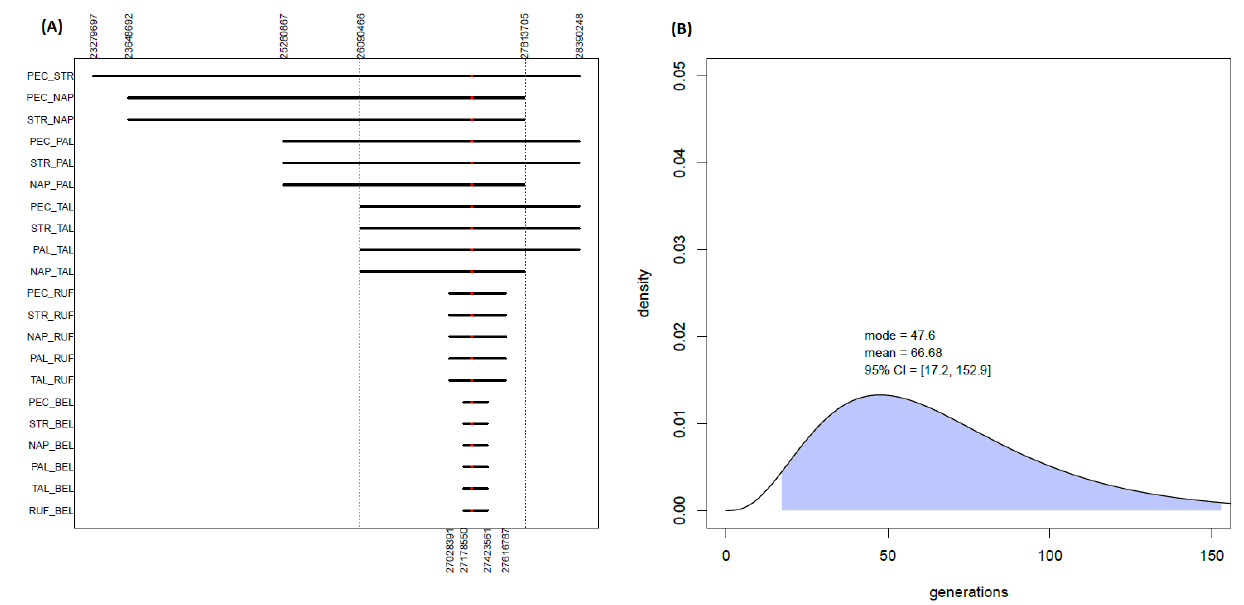
Figure 2. Sharing of extended genomic regions and tMRCA estimation. ( A ) Observed genomic regions tagging the APPA713T mutation shared among pairs of patients. The blue vertical bars highlight the genomic region of 300 SNPs and 1.7 Mbp shared among five of the seven patients. ( B ) Estimated tMRCA based on the highlighted genomic region.